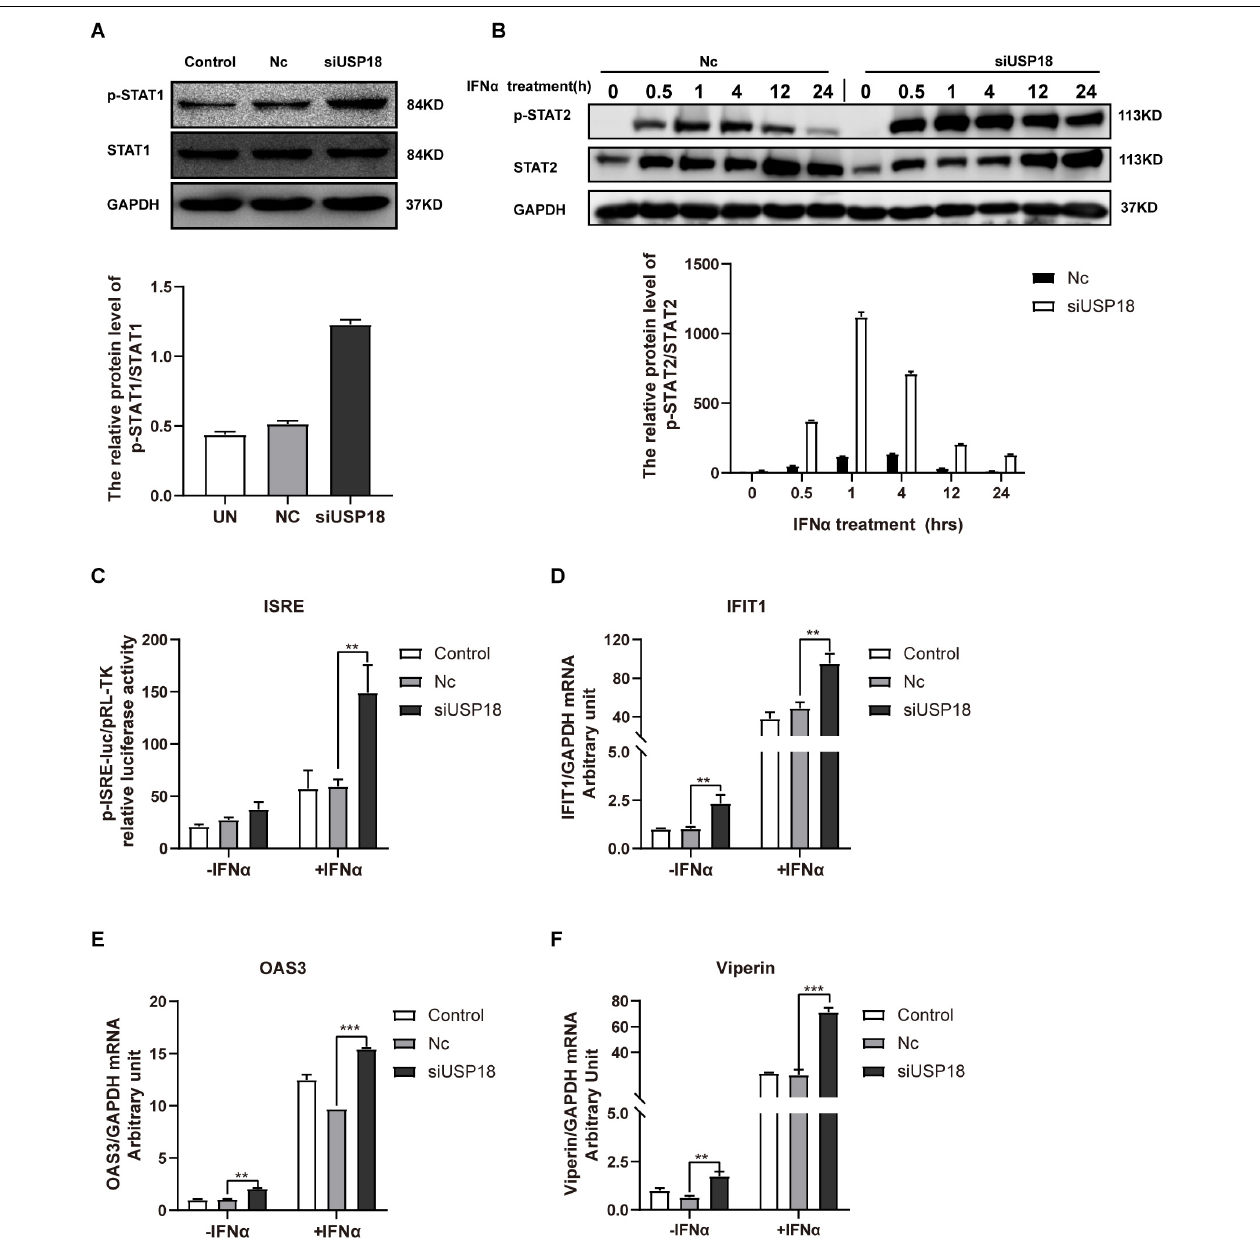
FIGURE 5 | Silencing of USP18 enhanced the activation of the IFN- α -mediated Jak/STAT signaling pathway. Hela cells were transfected with siUSP18 or NC for 8 h before infected with DENV-2 (MOI = 1) for 48 h. The cells were treated with 100 IU/mL IFN- α and harvested 30-min post-treatment. Protein levels of p-STAT1 and STAT1 were analyzed by Western blot with GAPDH as a loading control (A) . The cells were treated with 100 IU/mL IFN- α and harvested at 0.5, 1, 4, 12, and 24 h post-treatment. Protein levels of p-STAT2 and STAT2 were analyzed by Western blot with GAPDH as a loading control (B) . ISRE activity was determined by Dual-luciferase reporter gene assay (C) . Expression levels of IFIT1, OAS3, and Viperin were examined by real-time PCR, and results were normalized to GAPDH, yielding arbitrary units (fold change) (D–F) . Control is cells infected with DENV-2 only. –IFN α is without IFN- α treatment, and +IFN α is with IFN- α treatment. Data are presented as mean ± SD; Error bars indicate SD; ** P < 0.01, *** P <